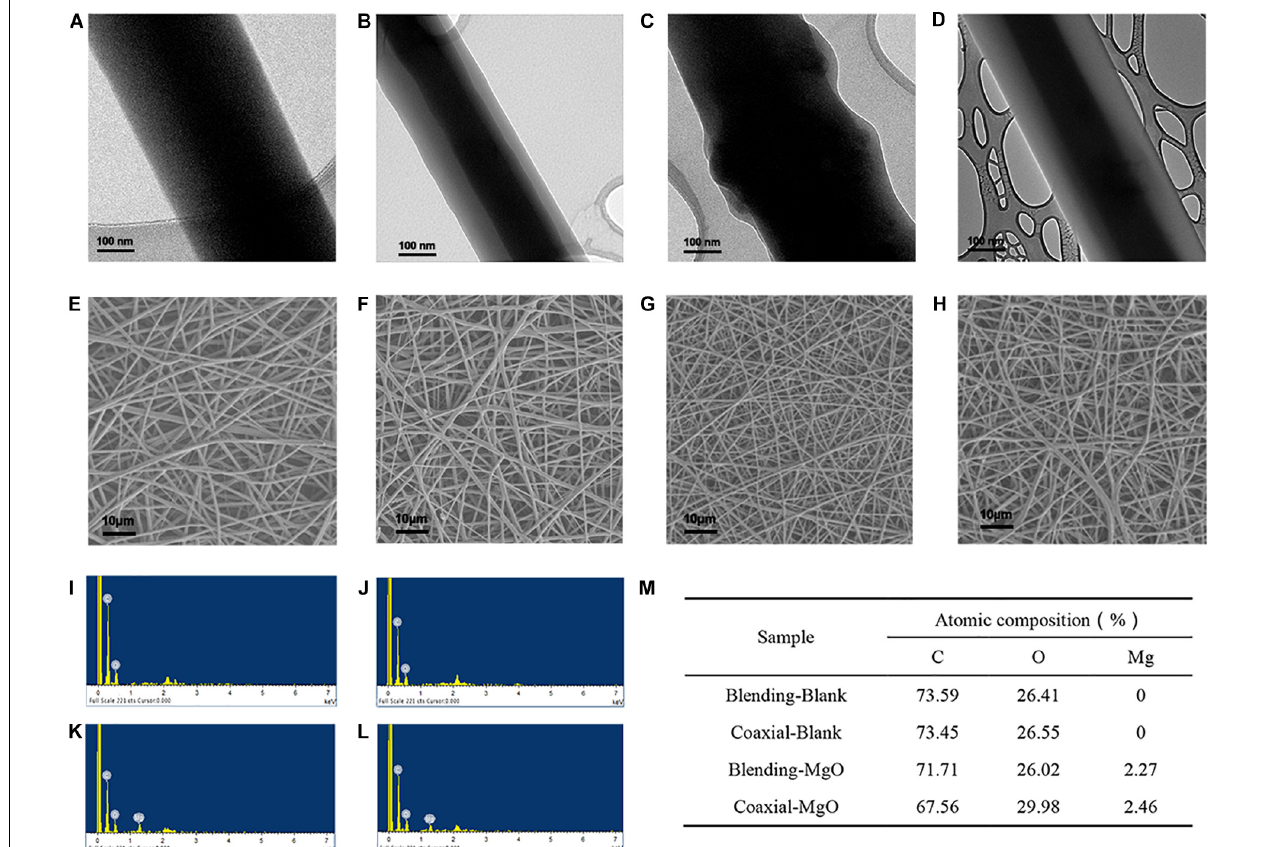
FIGURE 1 | Structure and characterization of four different electrospun membranes. TEM images of (A) Blending-Blank, (B) Coaxial-Blank, (C) Blending-MgO, and (D) Coaxial-MgO. SEM images of (E) Blending-Blank, (F) Coaxial-Blank, (G) Blending-MgO, (H) Coaxial-MgO. (I–L) EDS spectra of Blending-Blank, Coaxial-Blank, Blending-MgO, and Coaxial-MgO, respectively. (M) Semi-quantitative determination of elemental composition of these electrospun fiber surfaces. C, carbon; O, oxygen; Mg, magnesium.